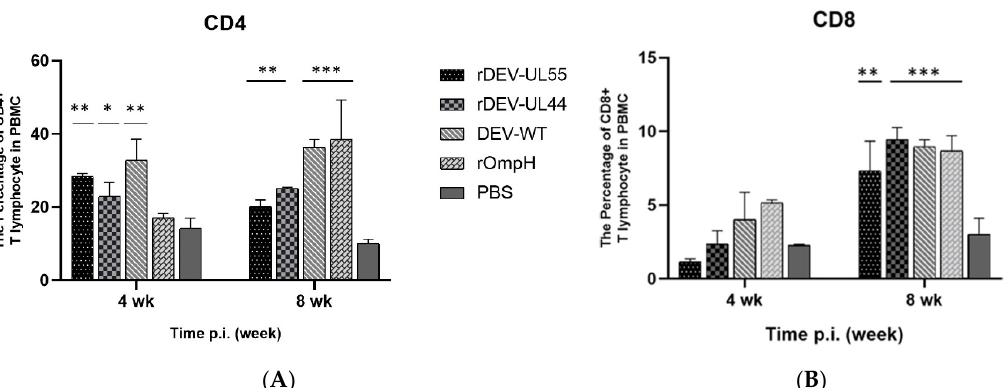
Figure 7. Analysis of CD4+ ( A ) and CD8+ ( B ) T lymphocytes in peripheral blood using flow cytom- etry at 4 weeks and 8 weeks post-vaccination. Statistically significant differences are indicated by (***) p < 0.001, (**) p < 0.01, and (*) p < 0.05 compared with the PBS control.